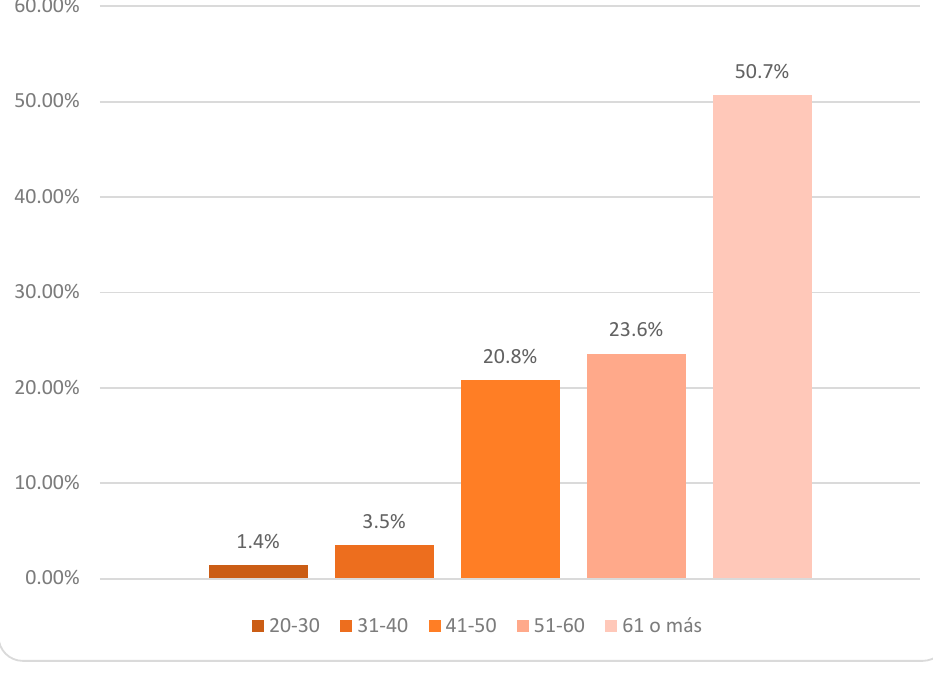
Figure 2. Sociodemographic: Age.